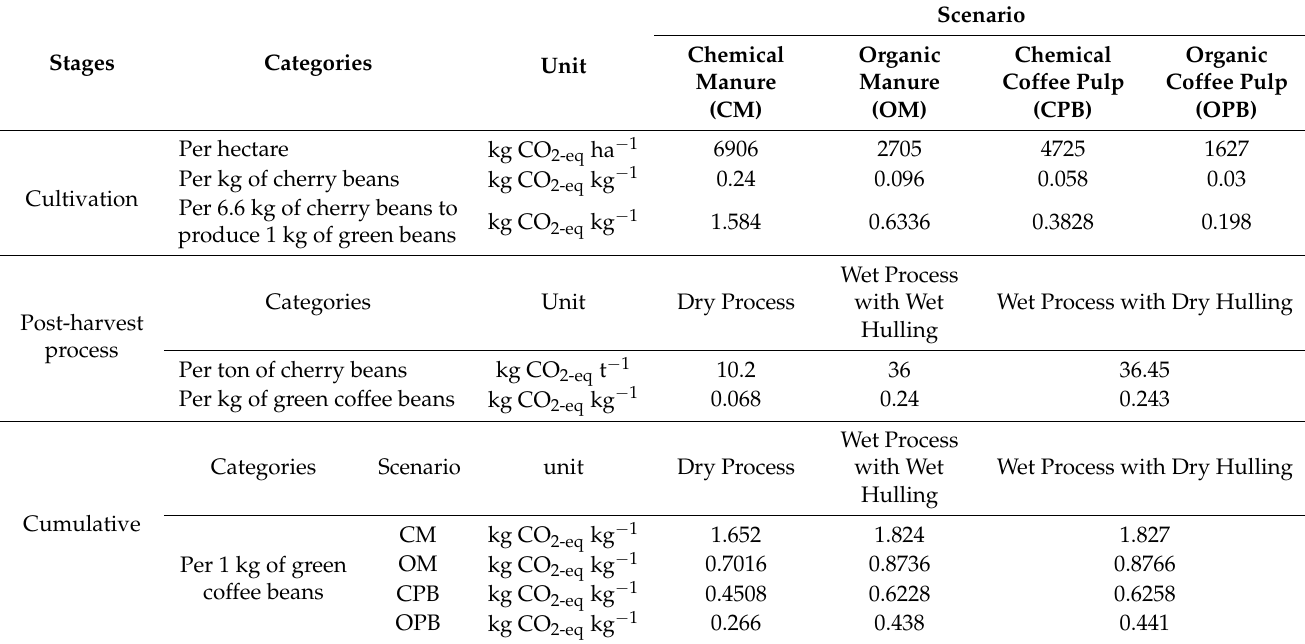
Table 2. Resum é of GWP impact in coffee